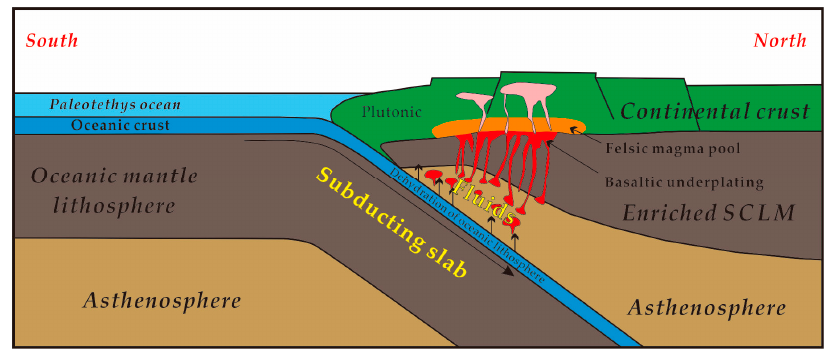
Figure 8. Schematic cartoon illustrating the petrogenesis of the ore-hosting diorite at Zaorendao and regional Triassic magmatism in the Tongren-Xiahe-Hezuo polymetallic district (modified after [12]). SCLM = sub-continental lithospheric mantle.